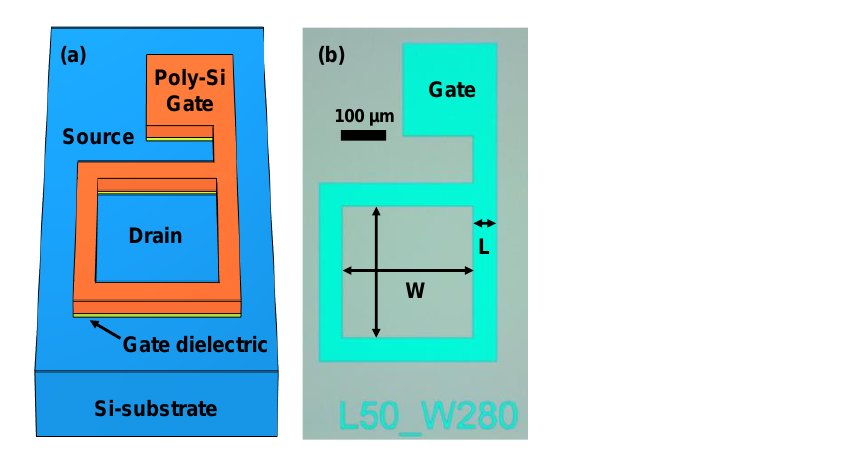
Figure 1. ( a ) Schematic and ( b ) optical microscope image of test vehicle on which silicon substrate is fabricated.